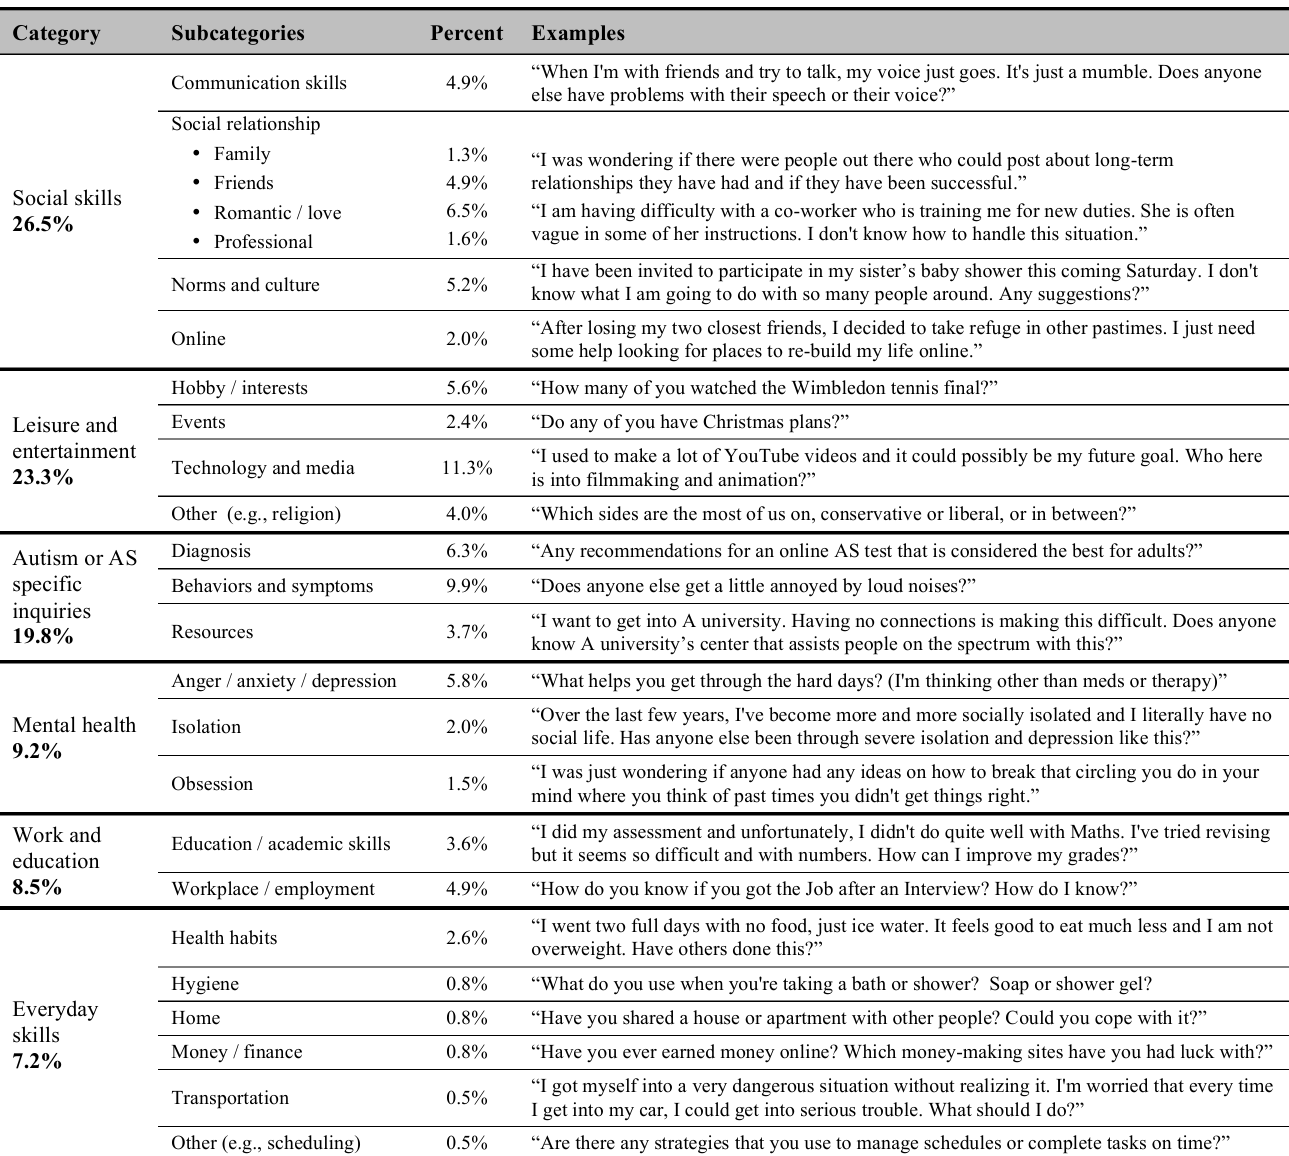
TABLE III. Q UESTION TOPIC CATEGORIES , SUB - CATEGORIES AND EXAMPLES